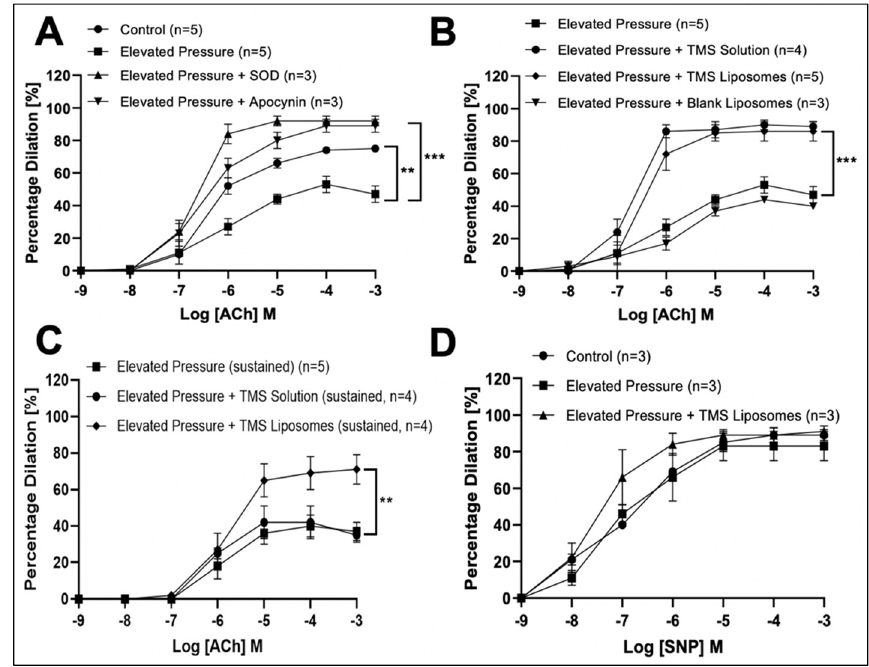
Figure 2. The influence of Tetramethoxystilbene (TMS)-loaded liposomes on vascular responses of isolated rat coronary arteries ex vivo. Endothelial-dependent acetylcholine (ACh)-induced responses in normotensive vessels exposed to standard pressure (control), acute pressure elevation ± superoxide dismutase (SOD) or apocynin ( A ). The influence of TMS/TMS-loaded liposomes on initial ( B ) and sustained (4 h after exposure to TMS) ( C ) on ACh-induced responses following acute pressure elevation. Endothelial-independent sodium nitroprusside (SNP)-induced responses in vessels exposed to standard pressure, acute pressure elevation ± TMS-loaded liposomes ( D ). All controls were subjected to standard pressure alone. Control ( n = 5); Elevated Pressure ( n = 5); Elevated Pressure + SOD ( n = 3); Elevated Pressure + Apocynin ( n = 3); Elevated Pressure + TMS Solution ( n = 4); Elevated Pressure + TMS Liposomes ( n = 5); Elevated Pressure + Blank Liposomes ( n = 3); Elevated Pressure (sustained) ( n = 5); Elevated Pressure + TMS Solution (sustained) ( n = 4); Elevated Pressure + TMS Liposomes (sustained) ( n = 4). The area under the curve for two groups were compared using Two-way ANOVA followed by Tukey’s multiple comparisons post-test. Data are presented as mean ± SEM. ** p < 0.01, *** p < 0.001.